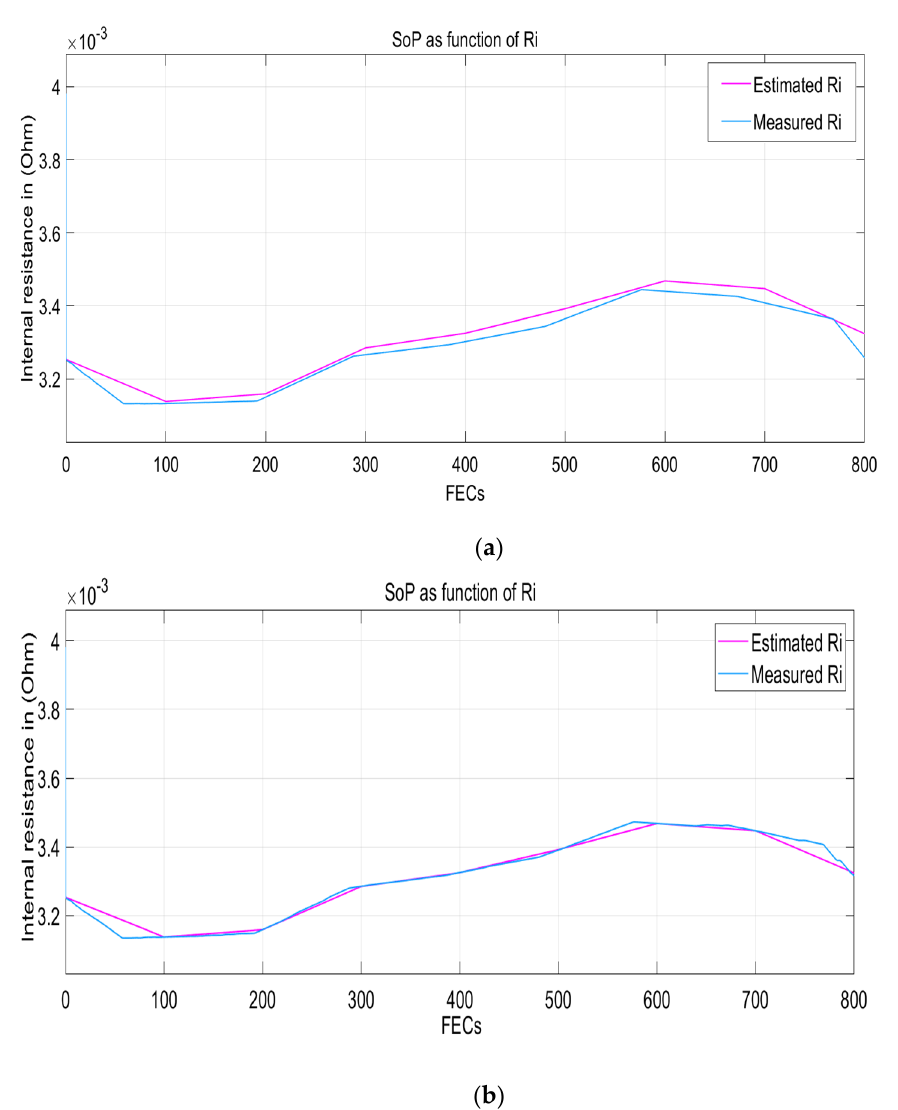
Figure 14. SoP validation as function of internal resistance using ( a ) WLTC profile; ( b ) static current profile.